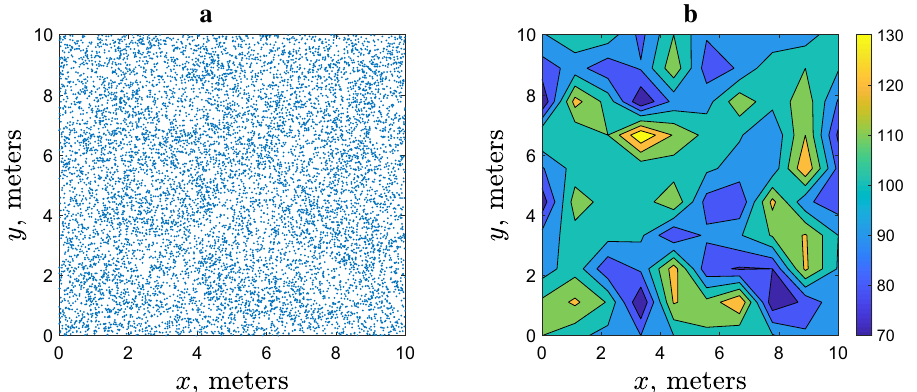
100 for R 1 (meters) and the = =